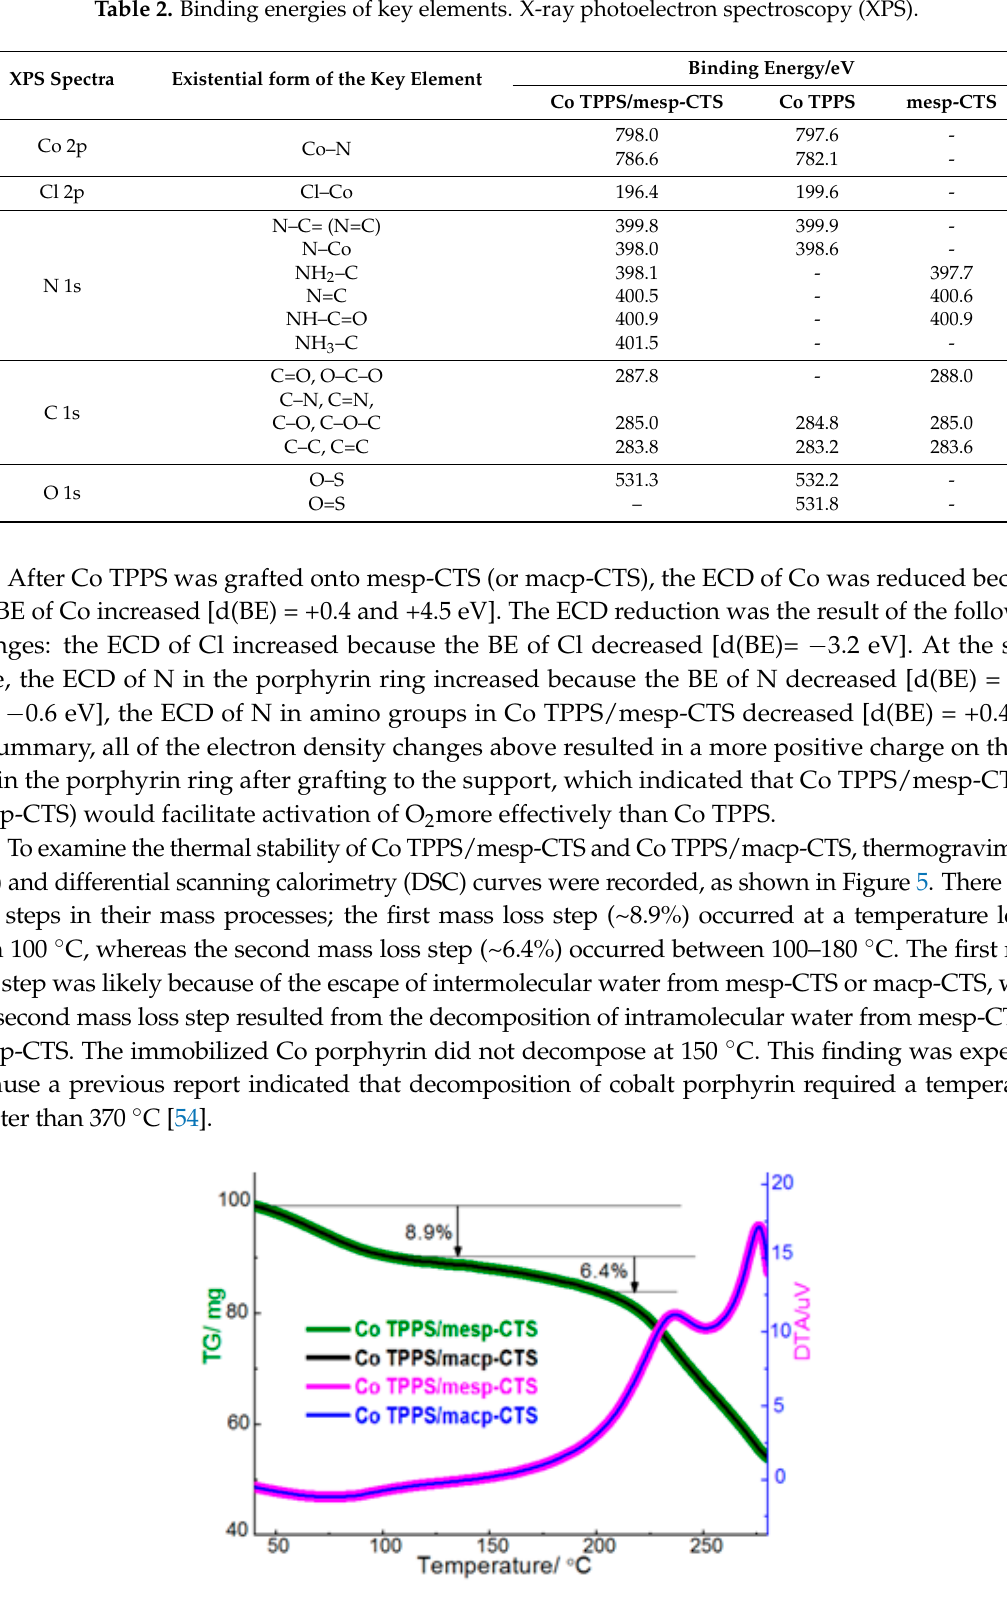
Figure 5. Thermo gravimetric (TG) and differential scanning calorimetry (DSC) analysis curves of Co TPPS/mesp-CTS and Co TPPS/macp-CTS.